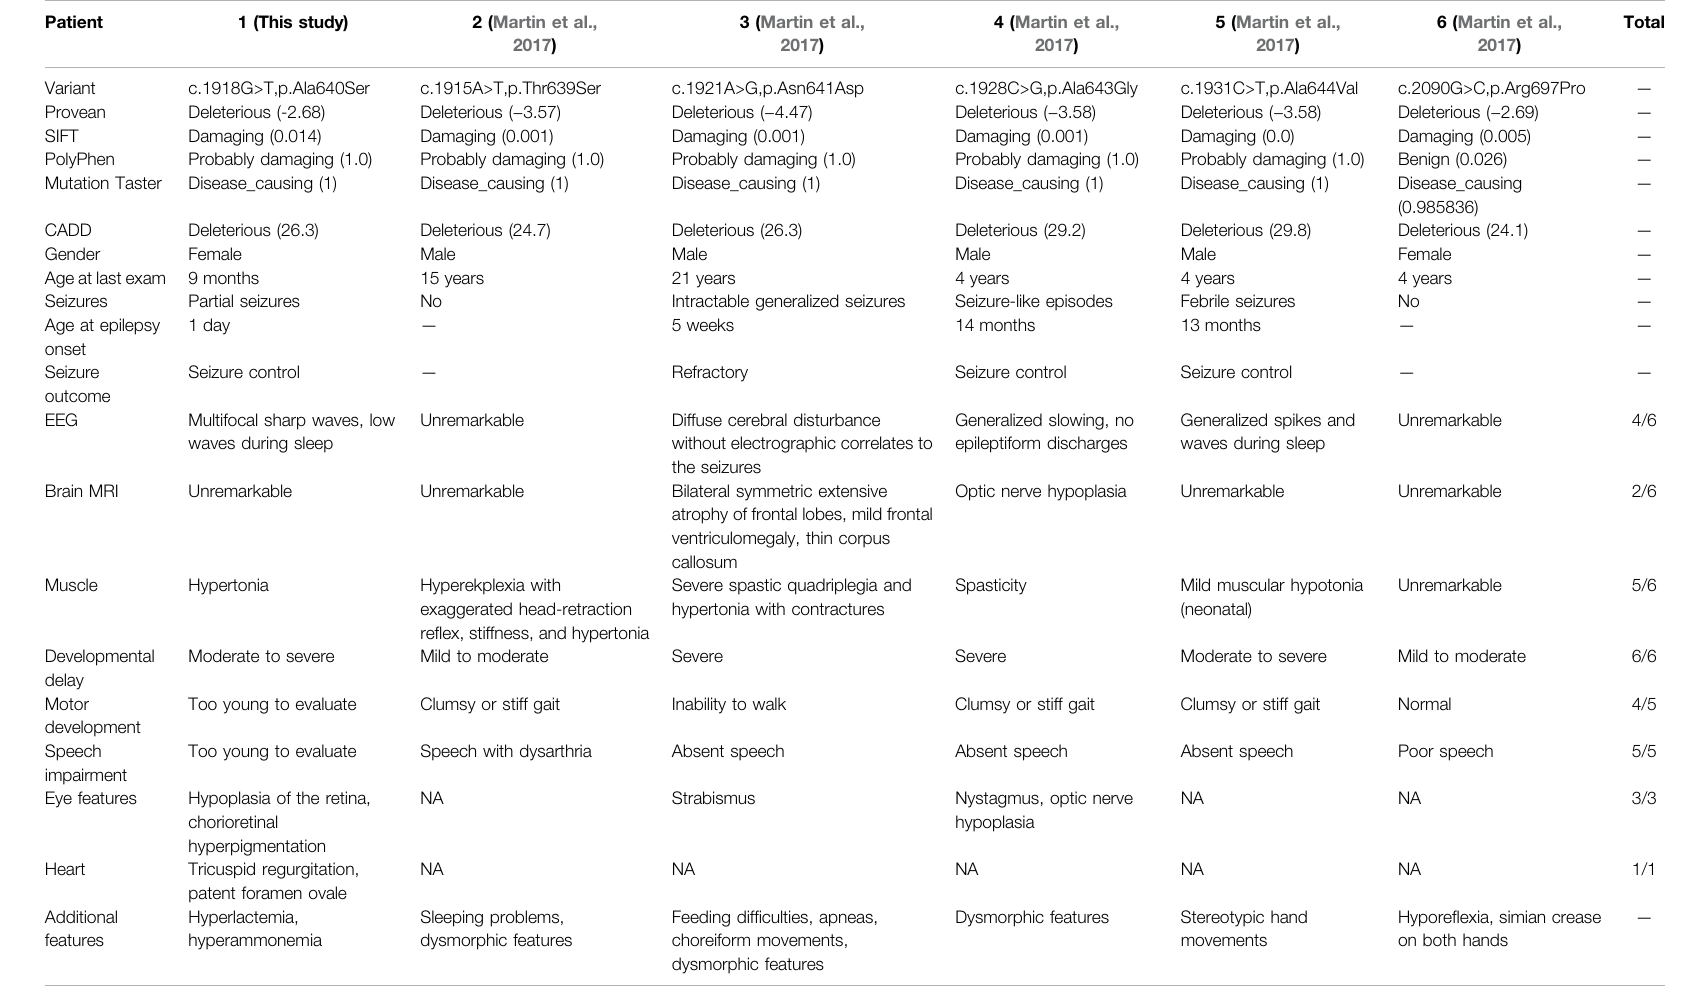
TABLE 1 | Clinical features of individuals with de novo GRIA4